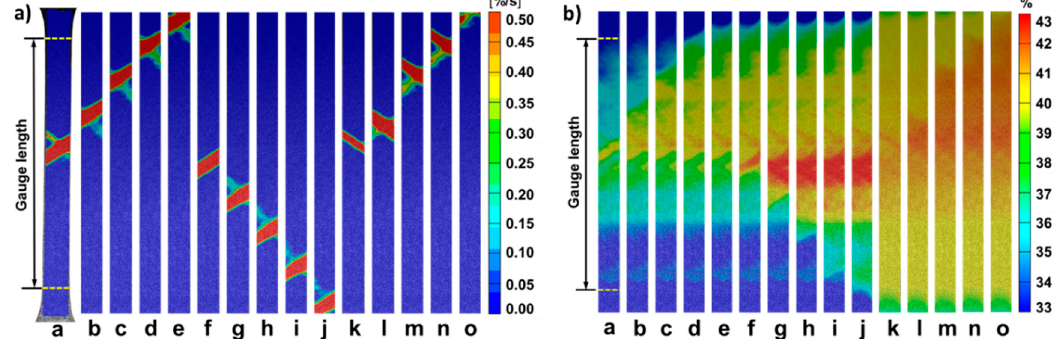
Figure 2. PLC bands ( a ) and local strain distribution ( b ) in Figure 1b.